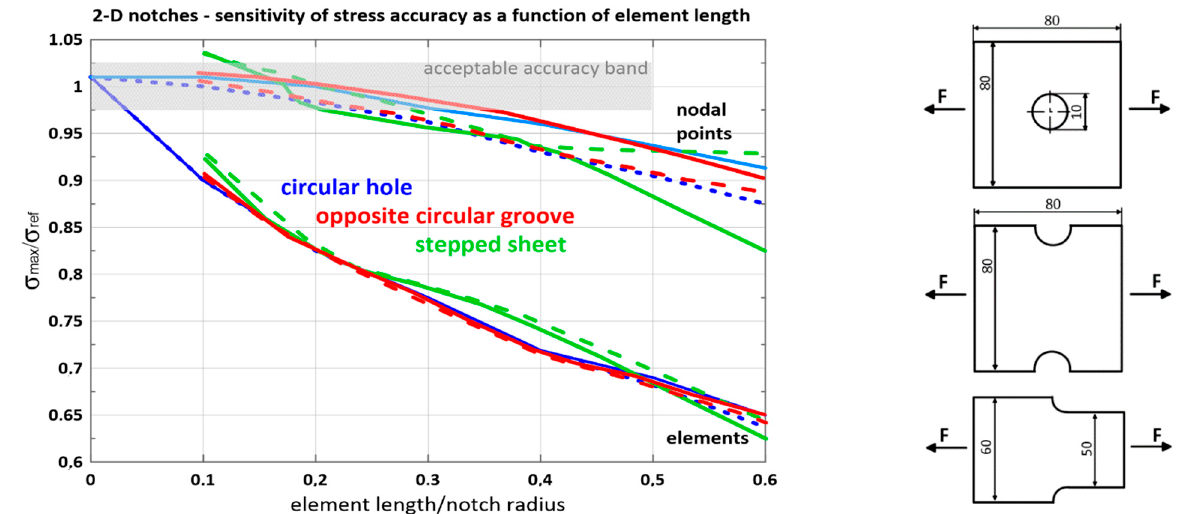
Figure 4. Analysis of the accuracy of notch root stress obtained by FEM simulation as a function of element mesh density for 3 selected cases of 2D notched components (dimensions are in millimeters): solid lines—linear elements; dashed lines—quadratic